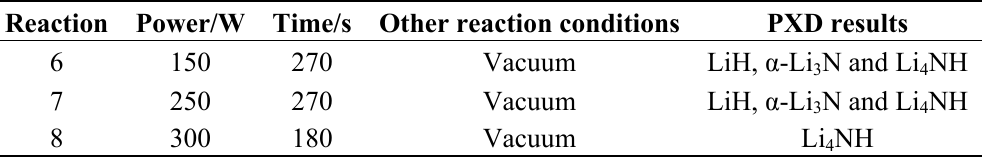
N + LiH reactions using a SMC reactor. 3